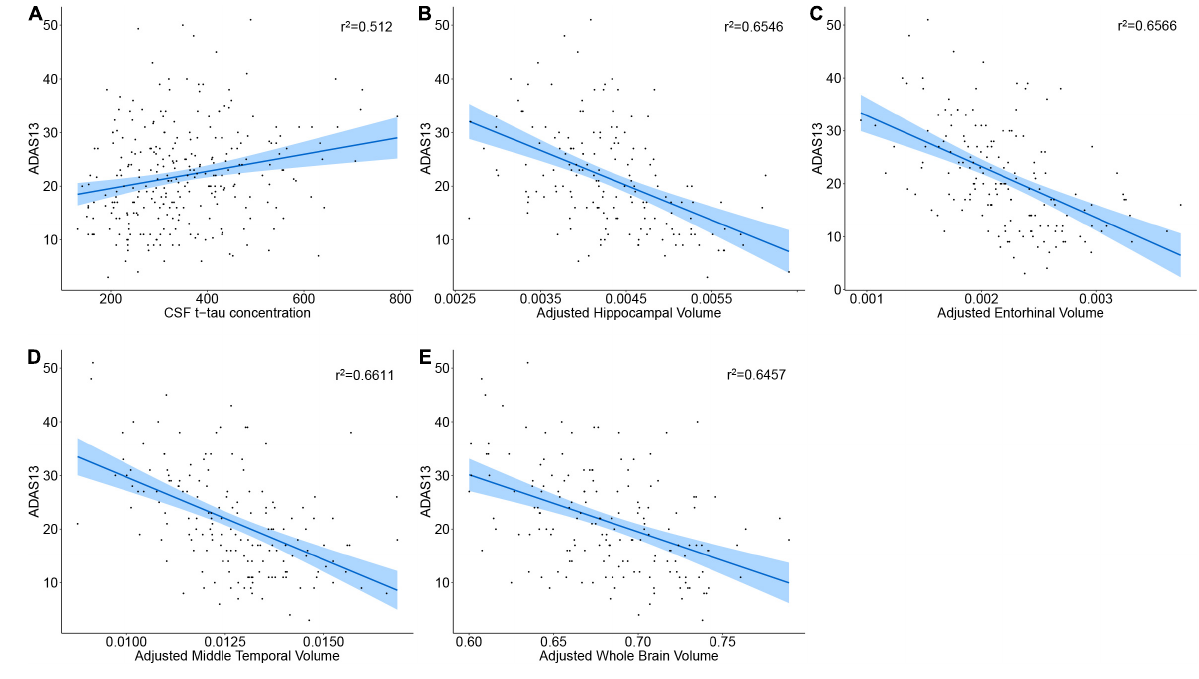
Frontiers in Aging Neuroscience |